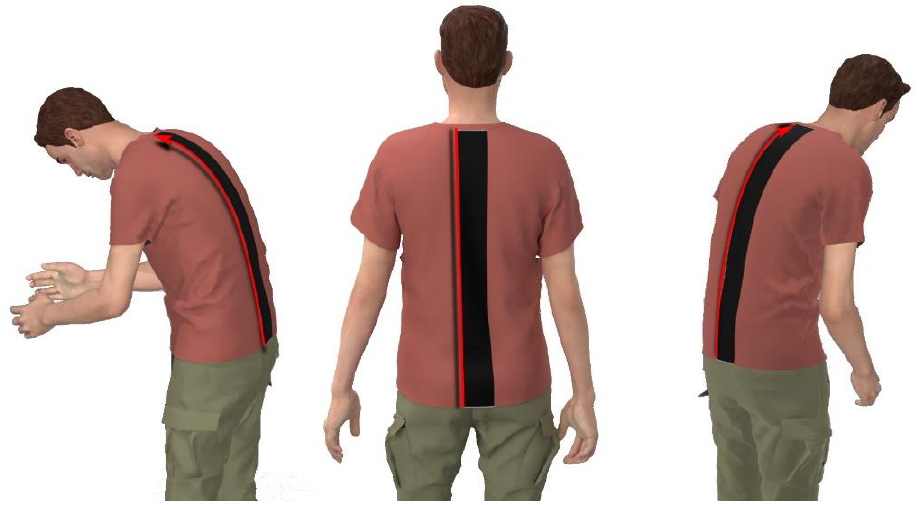
Figure 4. Placement and function of the motion sensor.